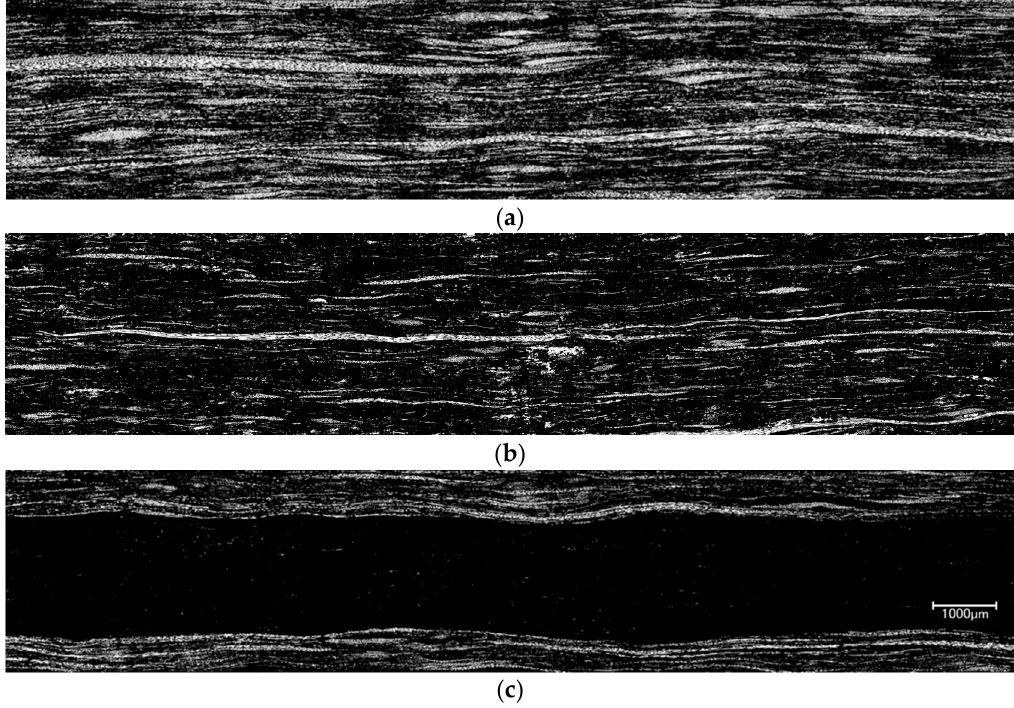
Figure 5. Visualisation of the typical rCF distribution shown as white areas. For the laminates 30rCF ( a ) and 22.5Flax-7.5rCF ( b ), the rCF should have been evenly distributed all over the composite. As not all fibres where fully opened, fibre rich areas as well as resin rich areas occurred. The laminate Gr-22.5Flax-7.5rCF ( c ) contains the same volumetric amount of rCF compared to ( b ), but is concentrated in both outer nonwoven layers. Micrographs were taken with Keyence VFX1000 and VH-Z100UR lens (×200) and stitched to a horizontal panorama. The image plane is the 90° laminate direction. All images were converted to black (flax, epoxy resin, voids) and white pixels (rCF) with the colour threshold tool in ImageJ software.